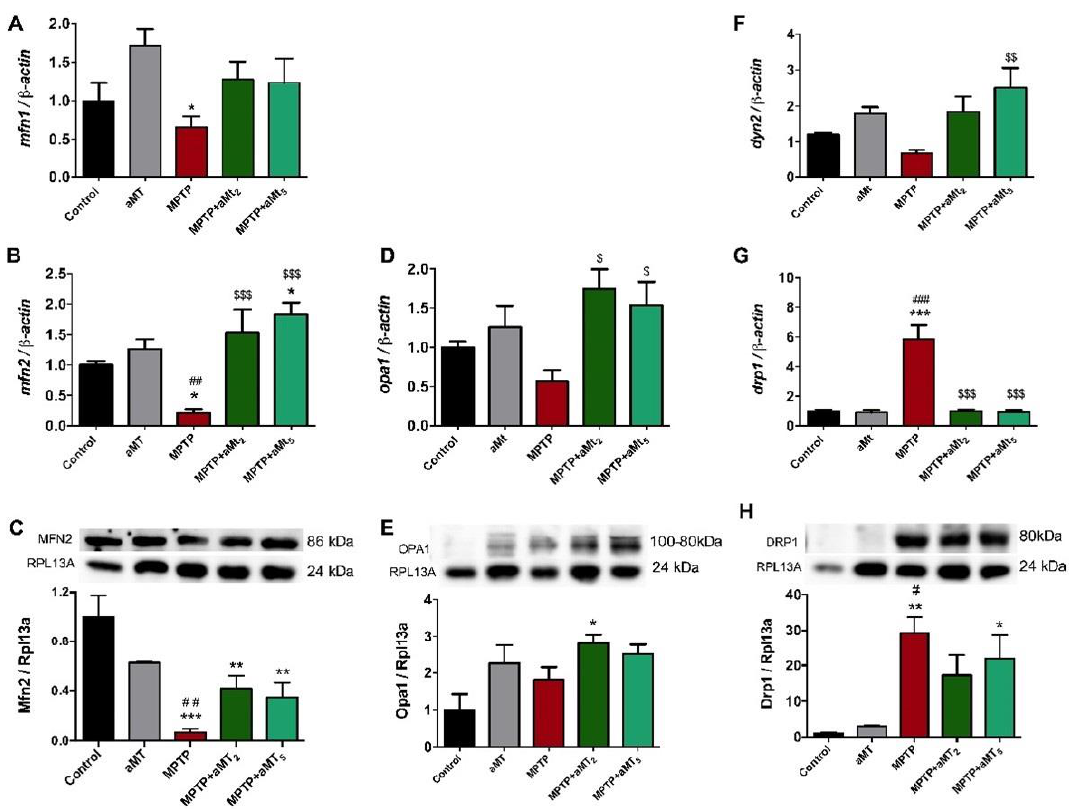
Figure 6. Analysis of the genes and proteins involved in mitochondrial dynamics. Regarding fission, the following markers were analyzed: ( A ) Expression of mfn1 mRNA; ( B ) Expression of mfn2 mRNA and ( C ) levels of Mfn2 protein in the same experimental groups; ( D ) Expression of opa1 mRNA and ( E ) levels of Opa1 protein in the same experimental groups. Fusion markers analyzed were: ( F ) dyn2 mRNA expression; ( G ) drp1 mRNA expression; and ( H ) Drp1 protein levels in the same experimental groups. Data are presented as mean ± SEM. * p < 0.05 versus control; ** p < 0.01 vs. control; *** p < 0.001 vs. control; # p < 0.05 vs. aMT; ## p < 0.01 vs. aMT; ### p < 0.001 vs. aMT; $ p < 0.05; $$ p < 0.01 vs. MPTP; $$$ p < 0.001 vs. MPTP. One-way ANOVA with a Tukey’s post hoc test.